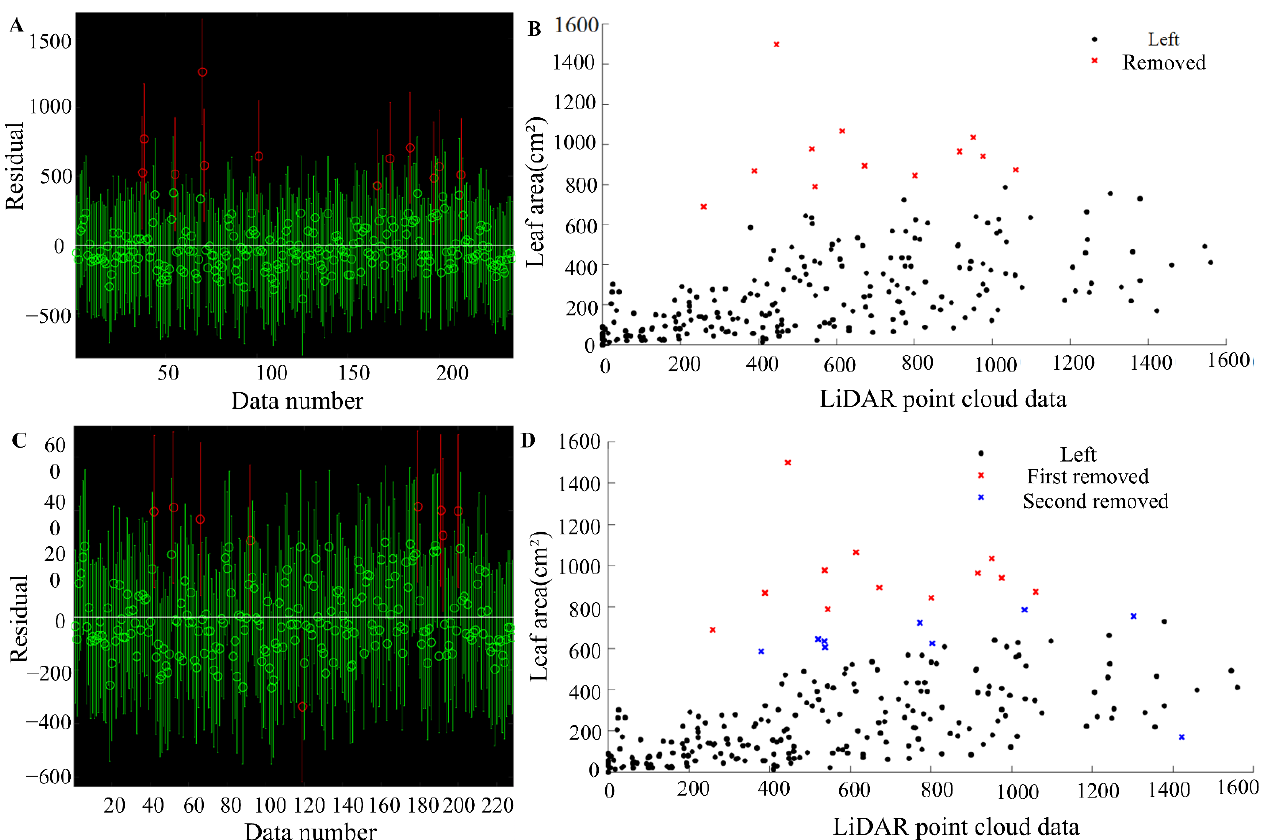
Figure 7. Comparison of residual maps and data after removal of outliers after one and two iterations. Residual graph from the first iteration ( A ) and the second iteration ( C ). ( B , D ) Comparison of the removal of outliers and residual values after one iteration and two iterations, respectively.